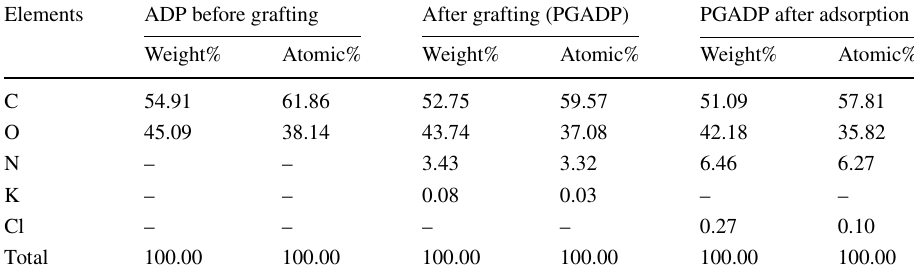
ADP, after grafting PGADP and after adsorption of crystal violet dye onto the surface of